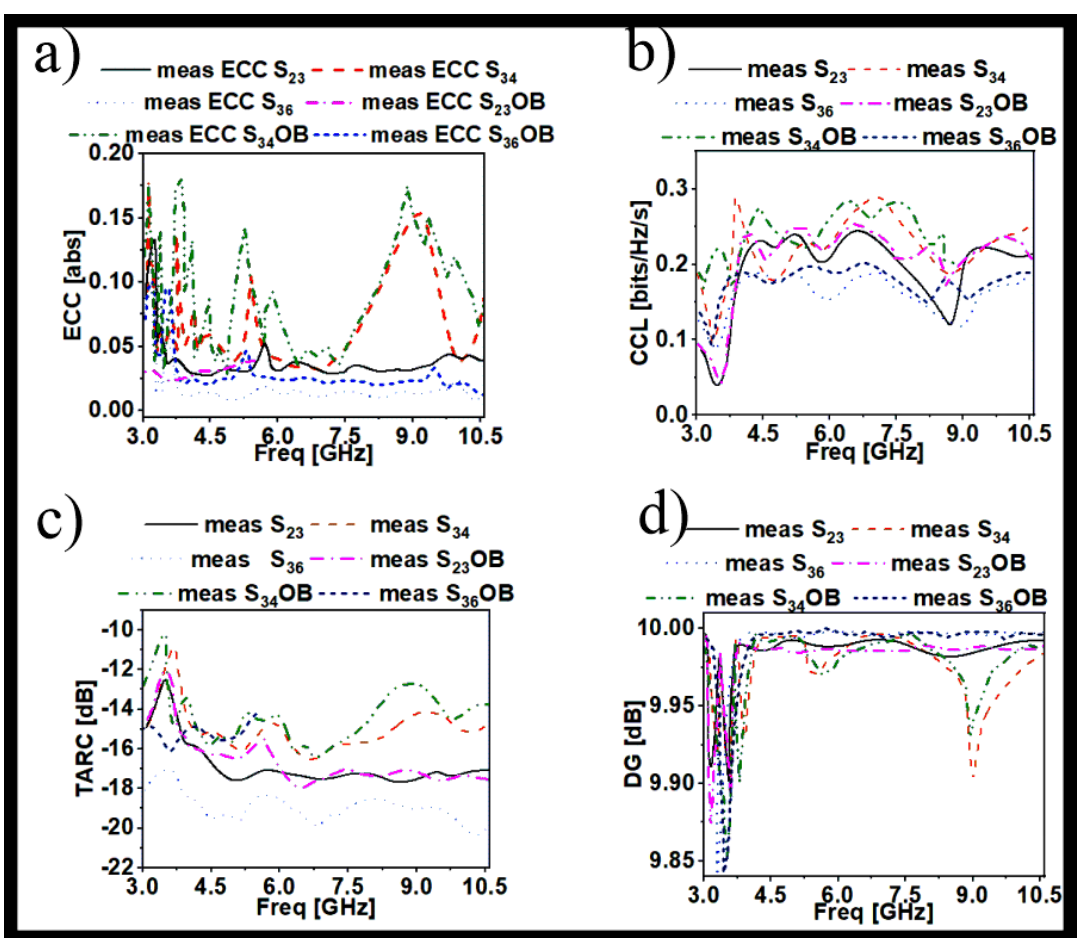
Figure 10. MIMO performance parameters: ( a ) CCL; ( b ) TARC; ( c ) ECC; ( d ) DG.